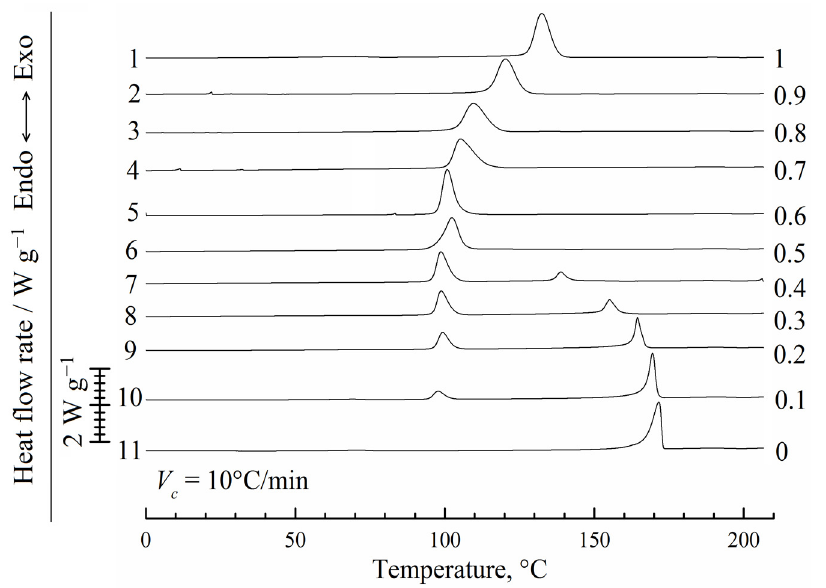
Figure 5. DSC cooling curves for PVDF, camphor, and their mixtures of different compositions recorded at a cooling rate V h = 10 ◦ C/min. Mass fractions of the polymer are shown to the right of the curves, which are arbitrarily shifted in the vertical direction.